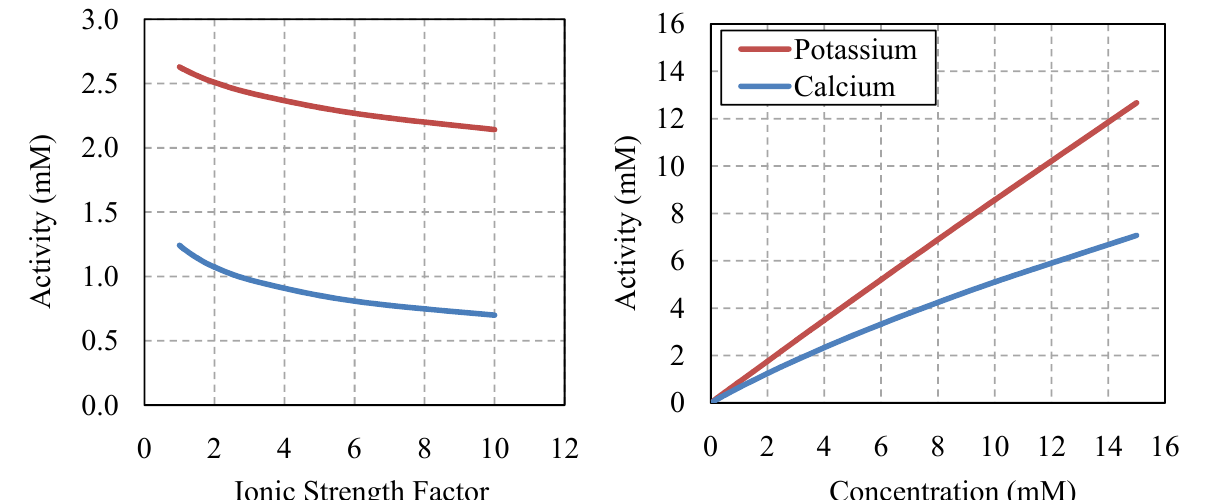
Figure 3. Examples of the distinction between activity and concentration for the monovalent ion potassium and divalent ion calcium within half strength Hoagland nutrient solution. ( Left ) Ionic activity changes for the fixed ion concentrations of potassium ([K + ] = 3 mM) and calcium ([Ca 2+ ] = 2 mM) in half strength Hoagland nutrient solution for changing ionic strength. The ionic strength factor is a ratio of the ionic strength of the solution compared with the ionic strength of the nominal half strength Hoagland nutrient solution. ( Right ) Activity versus concentration of potassium and calcium for nominal half strength Hoagland nutrient